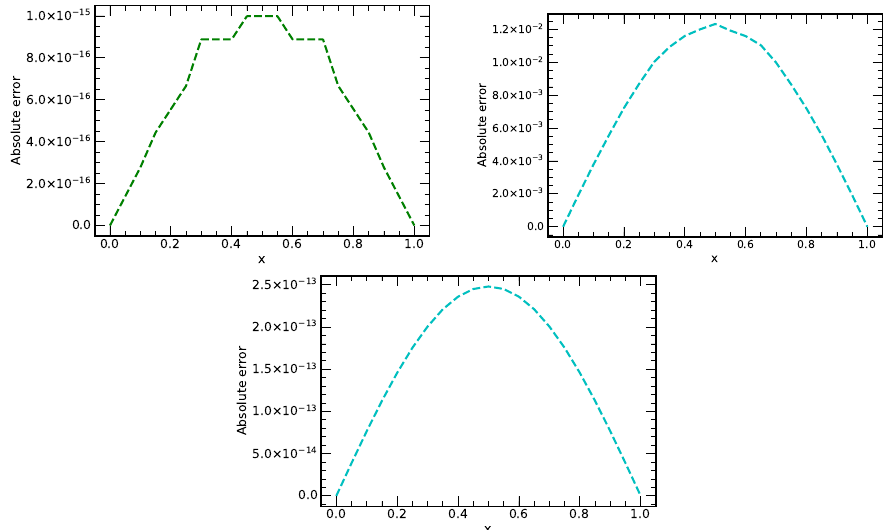
Figure 11. Plots for absolute errors at different values of t ( t = 0.05,0.07,0.10).